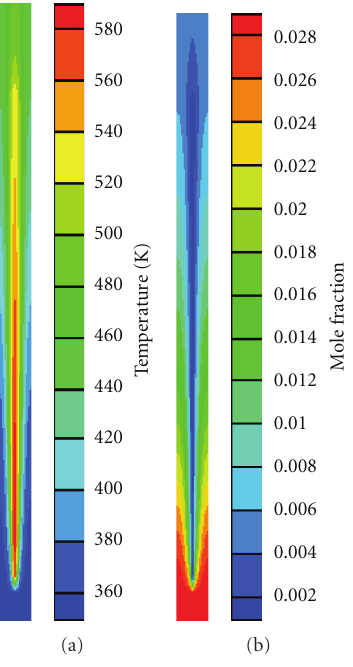
Figure 15: (a) Temperature contour and (b) hydrogen mole fraction contour zoomed view near catalyst plate for first steady- state condition